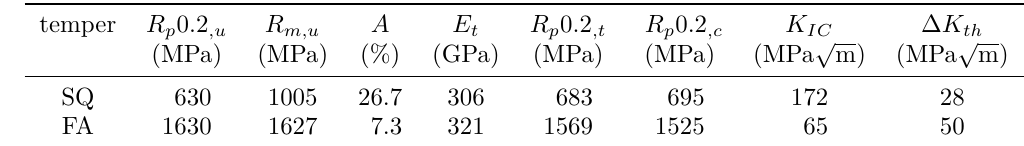
Table 2. Average values of global properties. Mechanical properties obtained by the uniaxial test are denoted by subscript u, subscript t and c denote properties in tension and compression obtained from four point bending test.